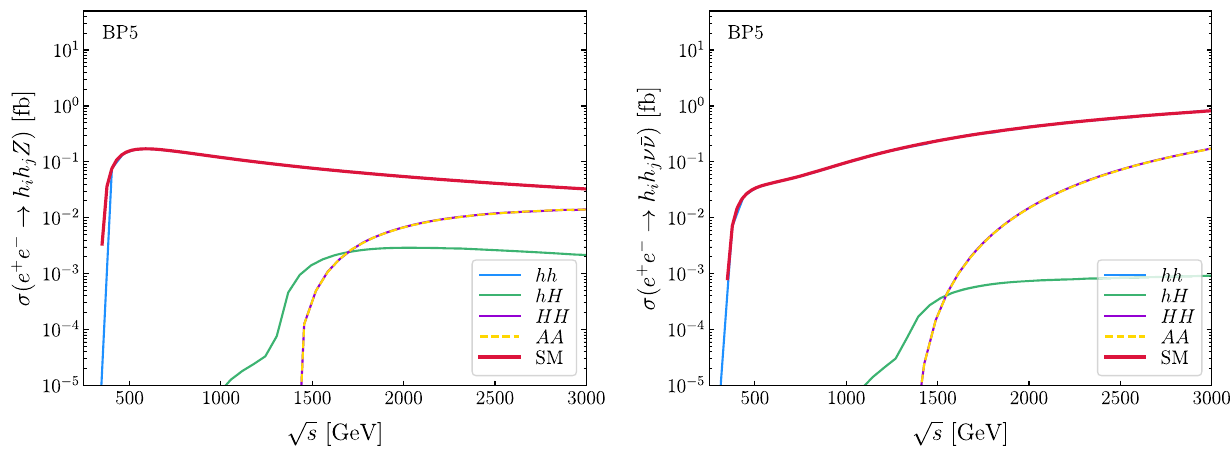
√ s for the processes e + e − → h i h j Z (left) and e + e − → h i h j ν ¯ ν (right) for